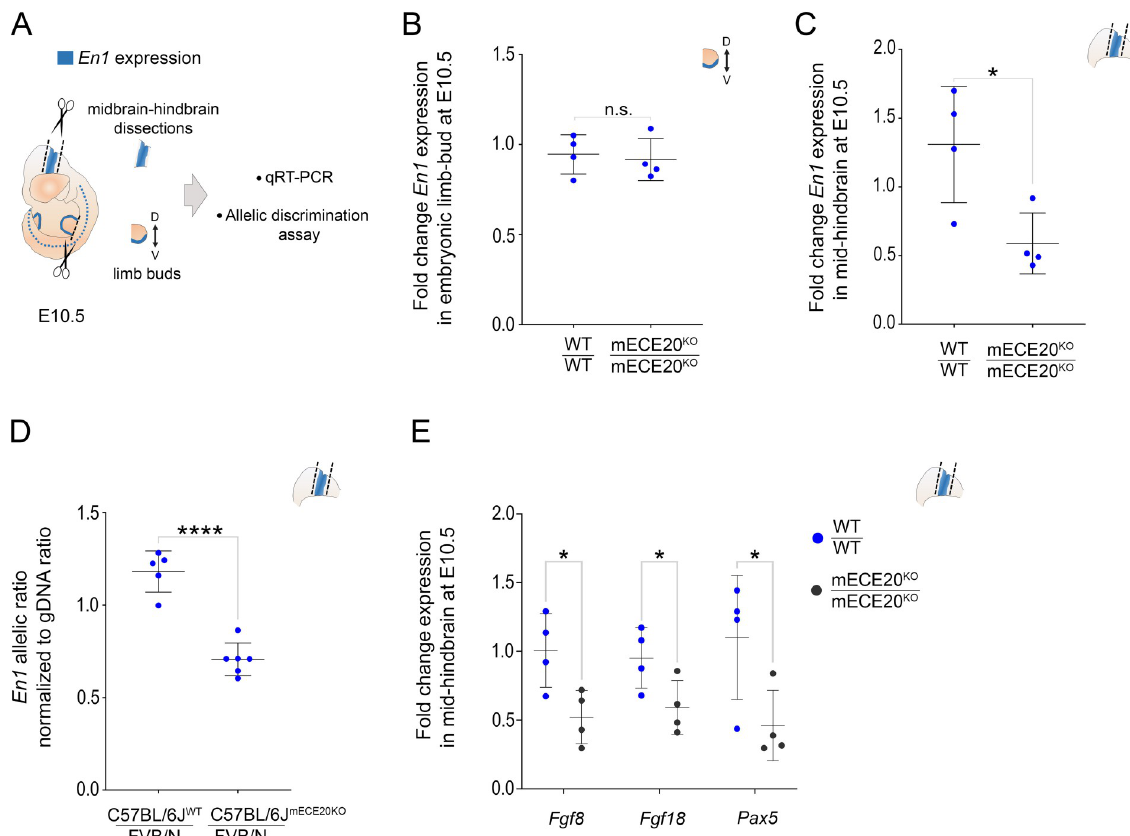
Fig 3. ECE20 has pleiotropic effects on En1 expression. (A) Schematic of mouse embryonic day (E) 10.5 tissues harvested for quantitative analyses of En1 expression. (B) Fold change En1 mRNA assessed by qRT-PCR from autopods of wildtype (WT / WT), and mECE20 KO homozygous (mECE20 KO / mECE20 KO ) mice at E10.5 relative to wildtype. (C) Fold change in En1 mRNA by qRT-PCR in midbrain- hindbrain tissue of wildtype (WT / WT), and mECE20 KO homozygous (mECE20 KO / mECE20 KO ) mice compared to wildtype at E10.5. (D) Fold change in Fgf8 , Fgf18 and Pax5 mRNA expression by qRT-PCR in midbrain-hindbrain tissue of wildtype (WT / WT), and mECE20 KO homozygous (mECE20 KO / mECE20 KO ) mice compared to wildtype at E10.5. (E) Normalized En1 mRNA allelic ratio in midbrain-hindbrain of wildtype (C57BL/6J WT / FVB/N) and mECE20 KO (C57BL/6J (mECE20KO) / FVB/N) hybrid mice. Ratios are normalized to the genomic DNA allelic ratio. In (B-E) each dot represents the mean value for an individual biological sample and the mean with standard deviation are plotted. In (B-E) significance assessed by a two-tailed T-test. ���� P < 0.0001, � P < 0.05, n.s. not significant. (KO) knock-out. In (B, C) Rlp13a was used as a housekeeping transcript for normalization. See also S3